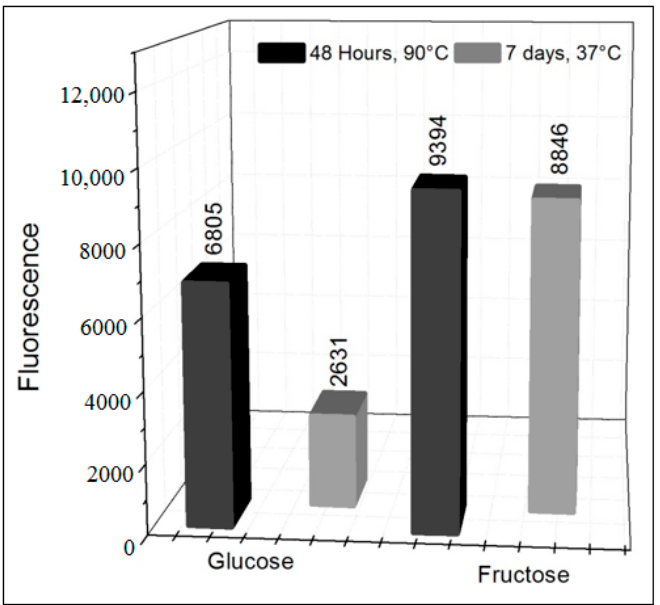
Figure 4. Formation of AGEs using glucose and fructose in the absence of XO in pure phosphate buffer (pH = 6.6) with incubation for 48 h (90 °C) and 1 week (37 °C).